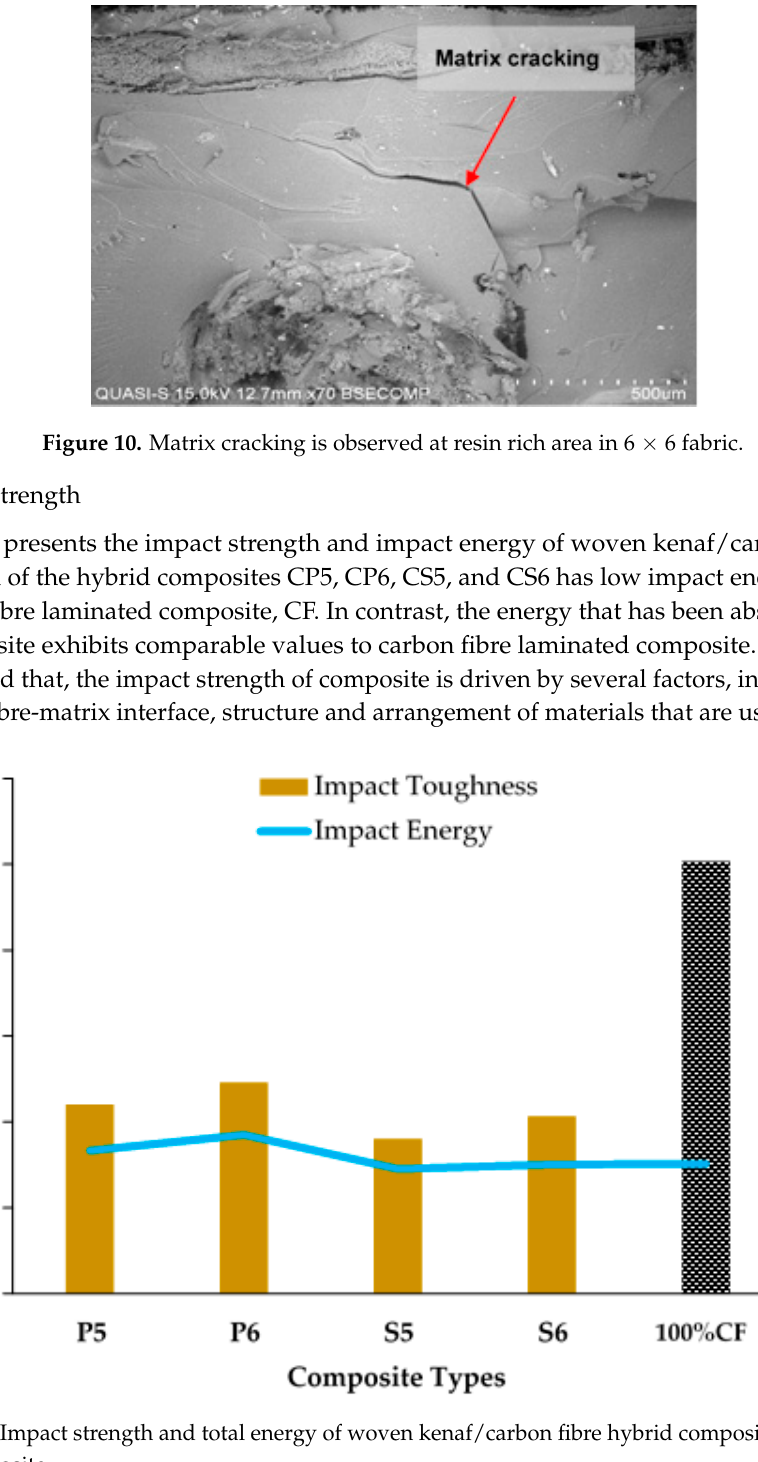
Figure 10. Matrix cracking is observed at resin rich area in 6 × 6 fabric.